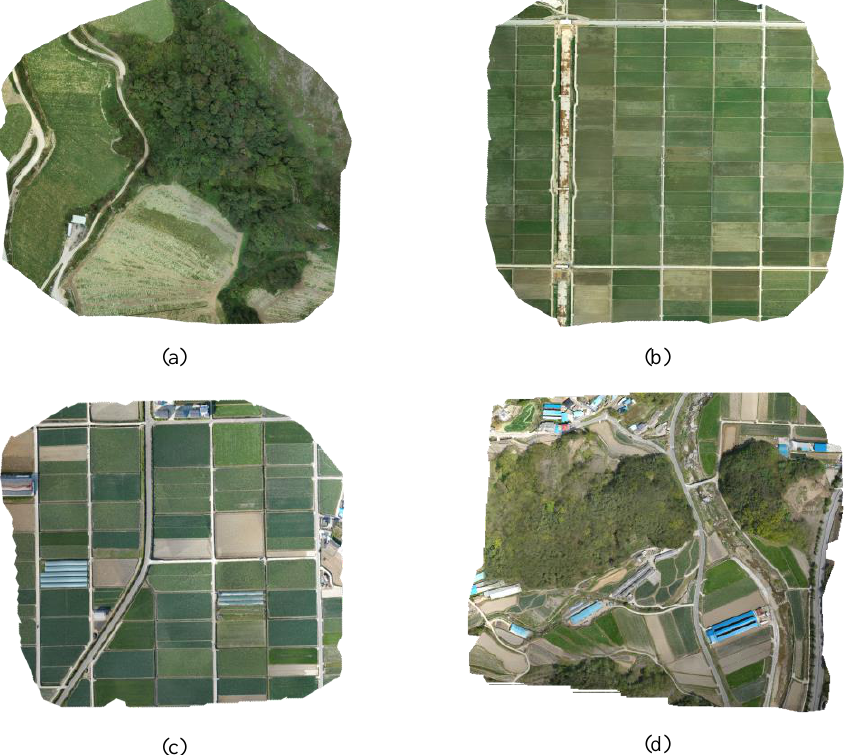
Figure 7. Mosaic images after applying the proposed method